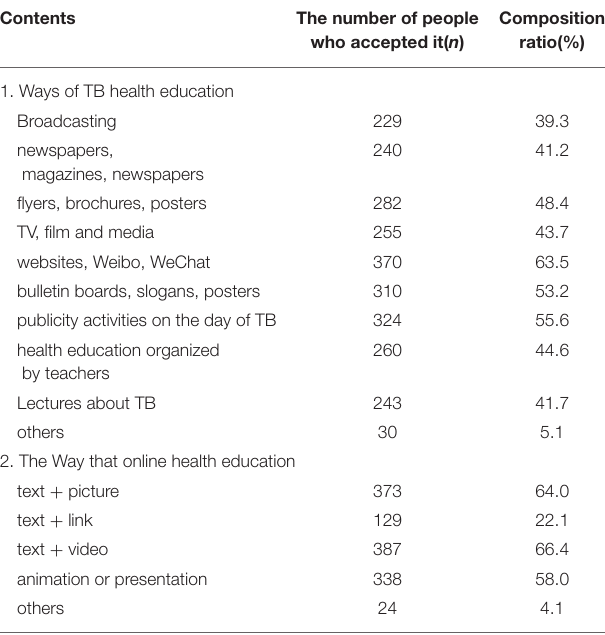
TABLE 6 | The willingness of freshmen to accept different ways of TB health education ( n =